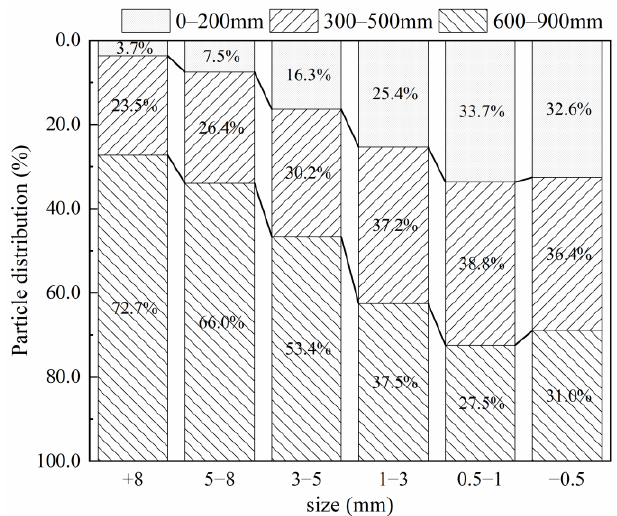
Minerals 2022 , 12 , x FOR PEER REVIEW 9 of 15